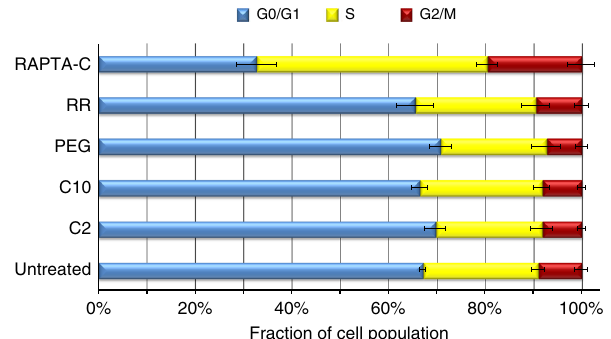
Fig. 4 Cell cycle analysis of binuclear and mononuclear RAPTA drug- treated cells. Cell cycle pro fi les are based on analysis of cultured tumour cells by fl ow cytometry (mean ± s.d., n